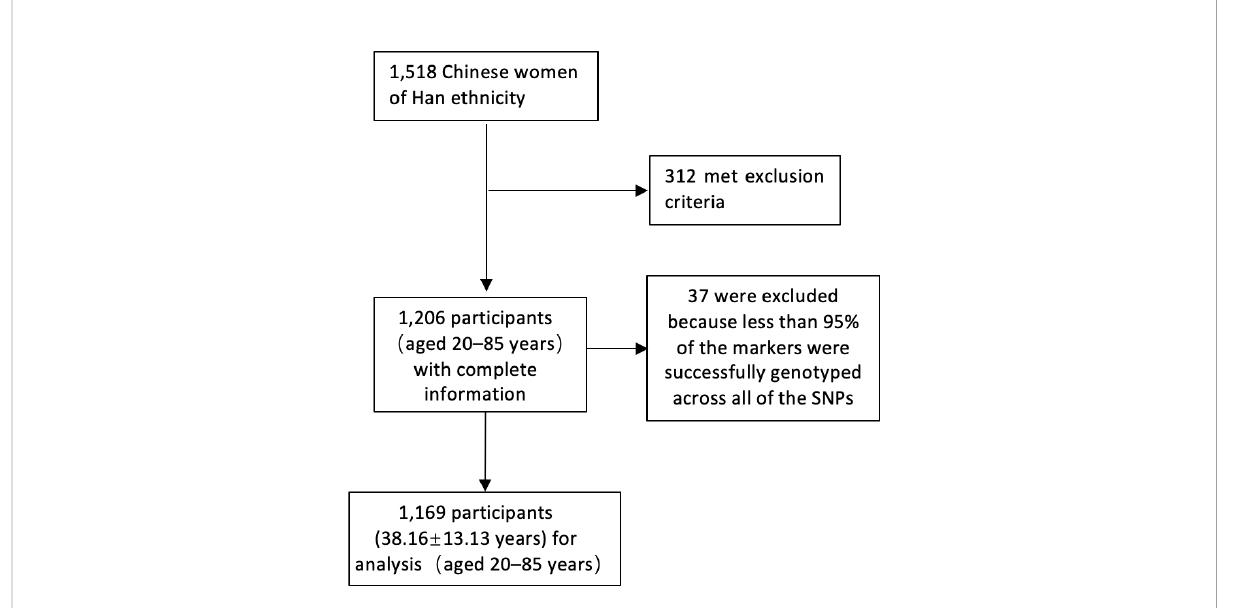
FIGURE 1 The inclusion process of the participants. SNP, single nucleotide